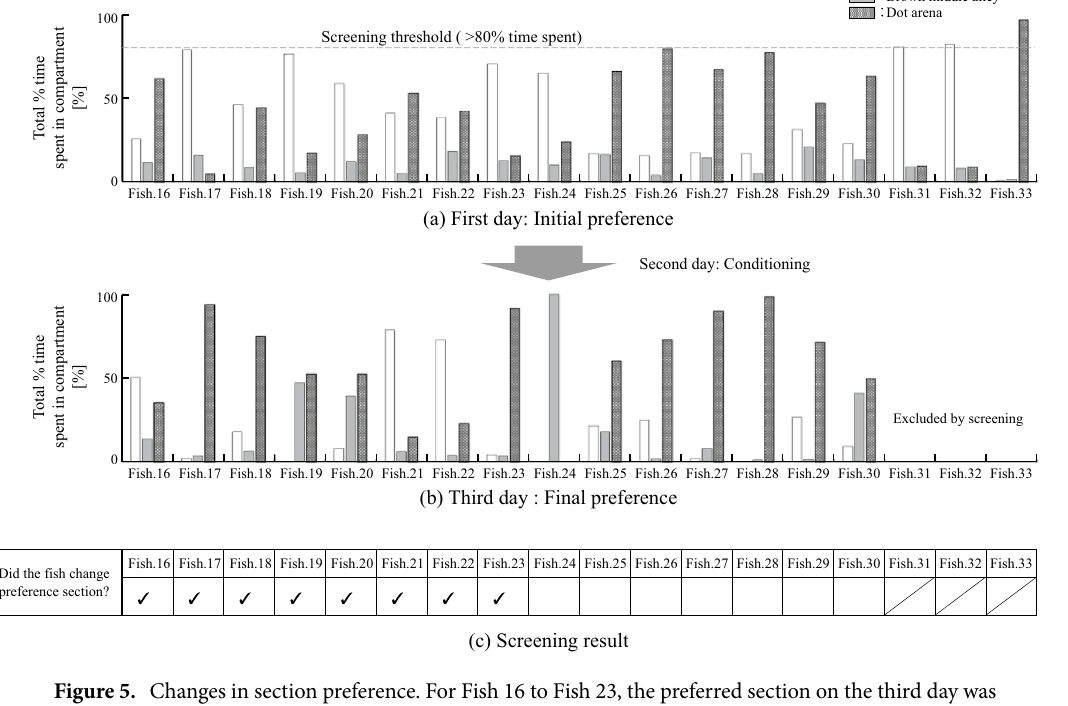
Figure 5. Changes in section preference. For Fish 16 to Fish 23, the preferred section on the third day was different from that on the first day.